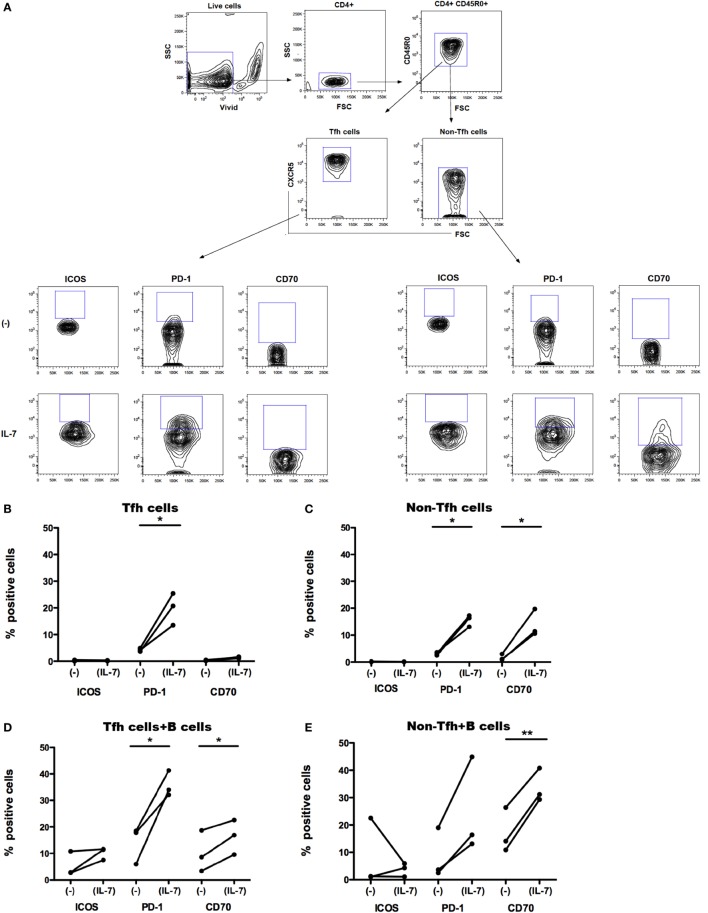
Effect of IL-7 and B cell coculture on ICOS, PD-1, and CD70 expression on blood T follicular helper (Tfh) and non-Tfh cells. The gating strategy for identification of Tfh cells in blood (A). Small CD4+ cells were identified by CD4 expression. Aggregates and dead cells were excluded by subsequent altered forward light scatter height–width ratios and dead cell dye uptake, respectively. Gated live memory CD4+ T (CD4+CD45R0+) single cells were then evaluated to identify Tfh cells (CD4+CD45R0+CXCR5+) and non-Tfh cells (CD4+CD45R0+CXCR5−). The frequency of ICOS+, PD-1+, and CD70+ cells was thereafter determined in Tfh and non-Tfh cells cultured in the presence and absence of IL-7. ICOS, PD-1, and CD70 expression on freshly sorted Tfh (CXCR5+) (B) and non-Tfh (CXCR5−) cells (C) cultured in the presence or absence of IL-7 for 6 days is shown. Frequency of ICOS, PD-1, and CD70 was also measured on Tfh (D) and non-Tfh cells (E) cocultured with B cells alone or with B cells in the presence of IL-7 for additional 7 days. Results of three independent experiments are shown. *p < 0.05, **p < 0.01. Freshly isolated peripheral blood mononuclear cells obtained from healthy controls (buffy coats) were processed to isolate CD4+ T cells by negative selection and stained with ViViD, PE-anti-CD4, FITC anti-CD45RO, and Alexa Fluor 647 anti-CXCR5 before sorting on a BD FACS Aria. Memory Tfh (CXCR5+) and non-Tfh (CXCR5−) cells were obtained at purities of >99%. Isolated Tfh and non-Tfh cells were washed and resuspended in RPMI medium supplemented with 10% fetal calf serum with or without IL-7 (25 ng/ml) for 6 days and cocultured with B cells for additional 7 days; the incubation times were selected according to previous experiments for optimal modulation of CD70 expression on T cells treated with IL-7 (30). For coculture of B cells with Tfh and non-Tfh cells, B cells were separated by negative selection using B cells isolation kit II (Miltenyi Biotech, Bergish Gladbach, Germany). Recombinant human IL-7 (Peprotech, London, UK) was used at a concentration of 25 ng/ml. The following fluorochrome-conjugated anti-human antibodies were used: V500 and PE-anti-CD4, FITC anti-CD45RO, PerCP-Cy5.5 and Alexa Fluor 647 anti-CXCR5, BV-421 anti-PD-1 (CD279), PE anti-ICOS (CD278), PE-Texas Red, and PE anti-CD70 (BD Pharmingen, San Diego, CA, USA). Viable cells were detected using Near-IR-Live/Dead (ViViD) kit (Invitrogen, Carlsbad, CA, USA). Fluorescence intensities were measured with LSRII (BD, San Jose, CA, USA), and data were analyzed using FlowJo version 8.8.7 (Tree Star Inc., Ashland, OR, USA). Wilcoxon matched pair t-test was used to compare the effect of IL-7 treatment on the expression of different surface molecules on Tfh and non-Tfh cells of the same individuals. Statistical analyses were performed using Prism (version 5.0a, GraphPad Software Inc., San Diego, CA, USA). The difference in CD127 MFI was tested with Kolmogorov–Smirnov test, and analyses were performed using unpaired t-test.